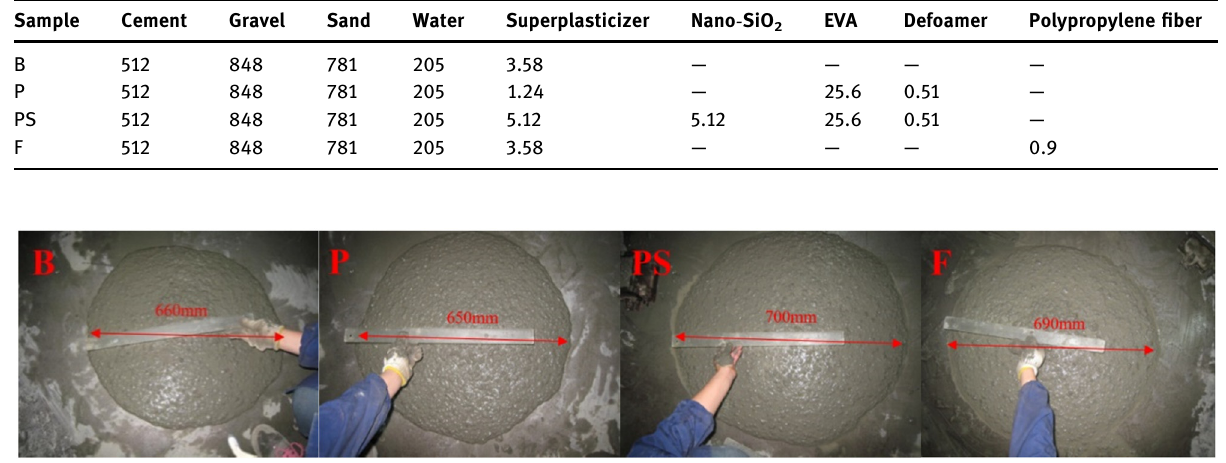
Figure 3: Spreading of fresh concrete.